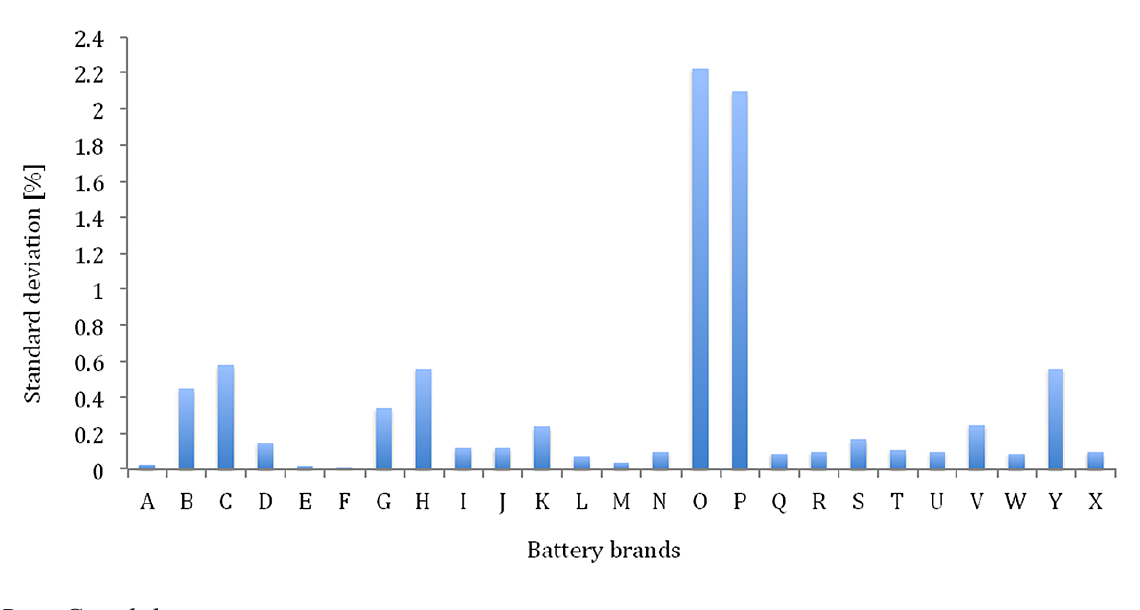
Figure 10. Standard variation of tested lithium-ion battery